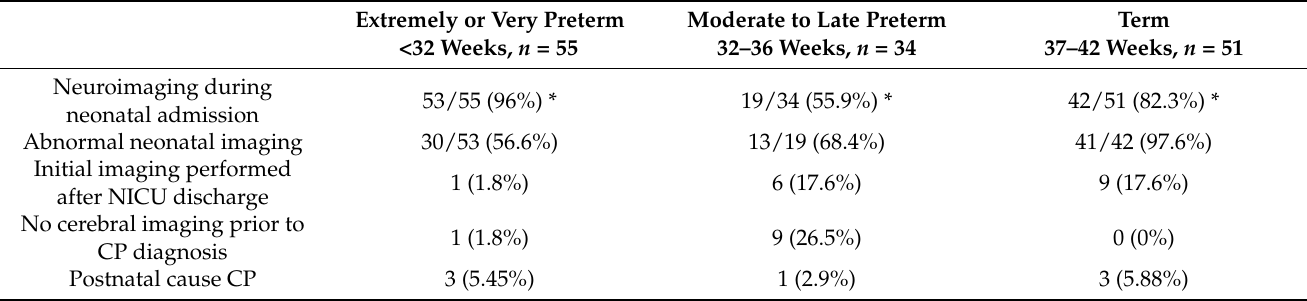
Table 2. Details of